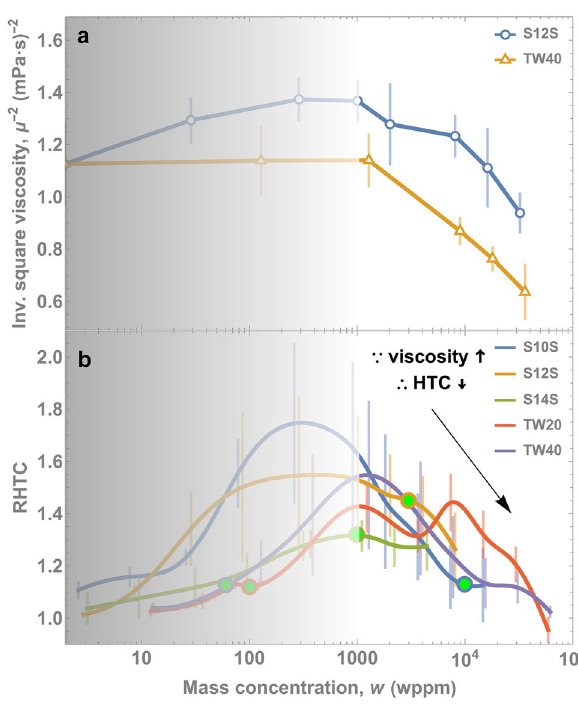
Figure 9. ( a ) The viscosity increases at high mass concentration values, which according to the Rohsenow correlation 50 , HTC ∝ μ -2 . Indeed, ( b ) there a corresponding drop in RHTC with the increase in viscosity. Error bars in viscosity (one standard deviation in data deviations from measurements of the drop velocity and the ball bearing diameter and density). For more information about the propagation of errors, see